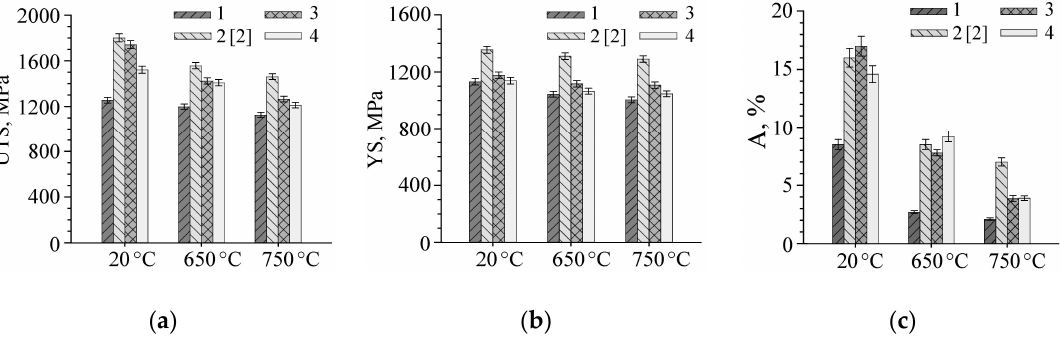
Figure 5. The tensile properties of the superalloy in conditions 1–4 obtained at 20, 650 and 750 °C: ( a )